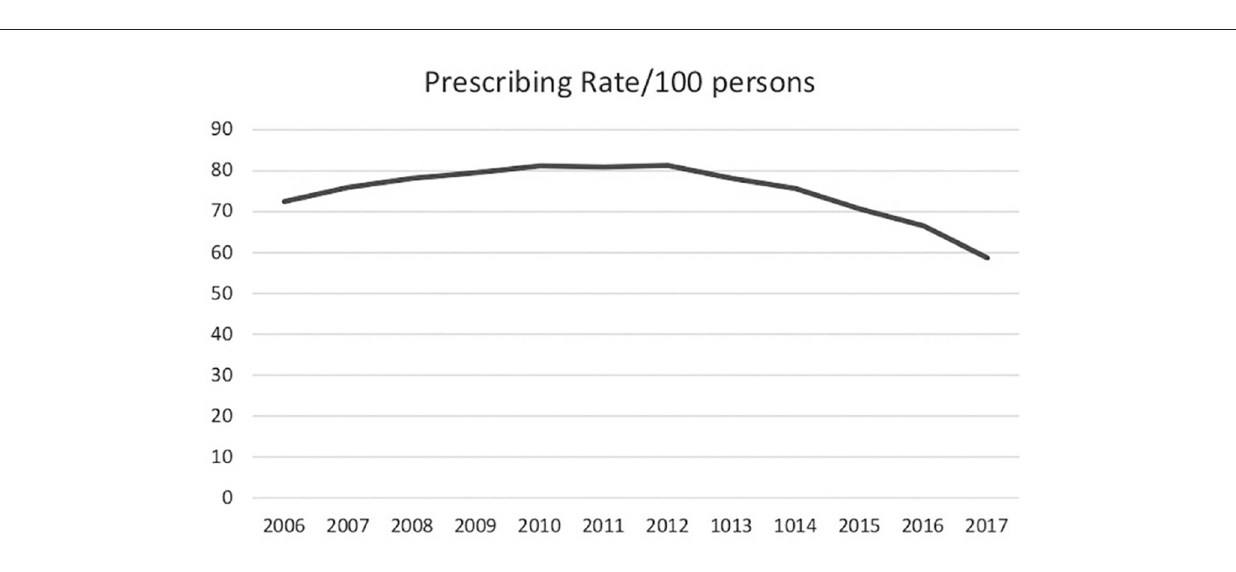
FIGURE 3 | United States annual opioid prescriptions rates/100 persons (110) (CDC